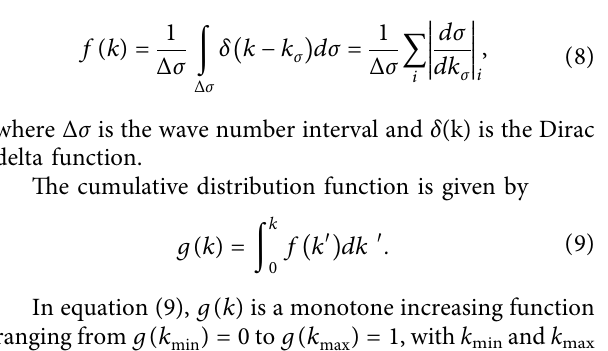
Figure 1: Schematic diagram of waveband division in the MSBK